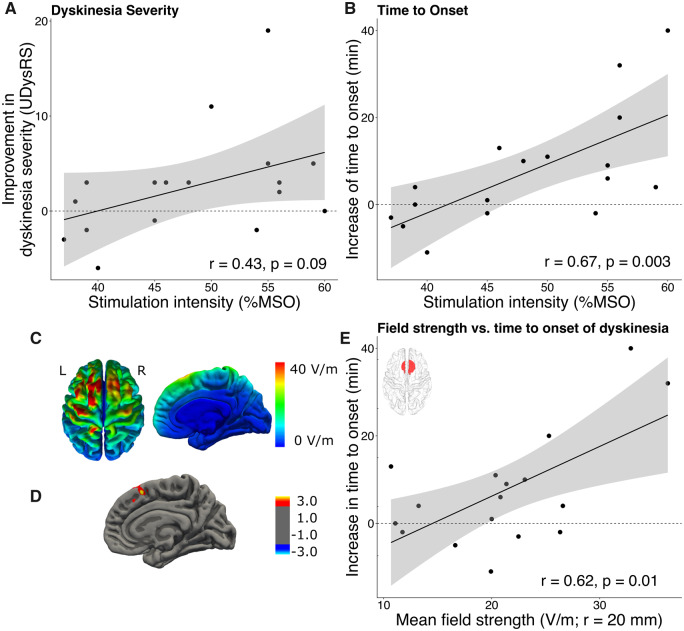

Dose-dependent effects of rTMS on clinical outcome measures. (A) Association between stimulation intensity and improvement in dyskinesia severity. (B) Association between stimulation intensity and prolongation of time between levodopa intake and the onset of dyskinesia. (C) Group mean rTMS-induced electrical field. (D) The rTMS-induced delay in dyskinesia onset correlated positively with the induced electrical field strength in preSMA. (E) Correlation between rTMS-induced delay in dyskinesia onset and mean induced electrical field strength in a sphere (r = 20 mm) centred at the stimulation target (MNI x, y, z = 4, 8, 58). Shaded areas around linear fits represent the 95% confidence interval.